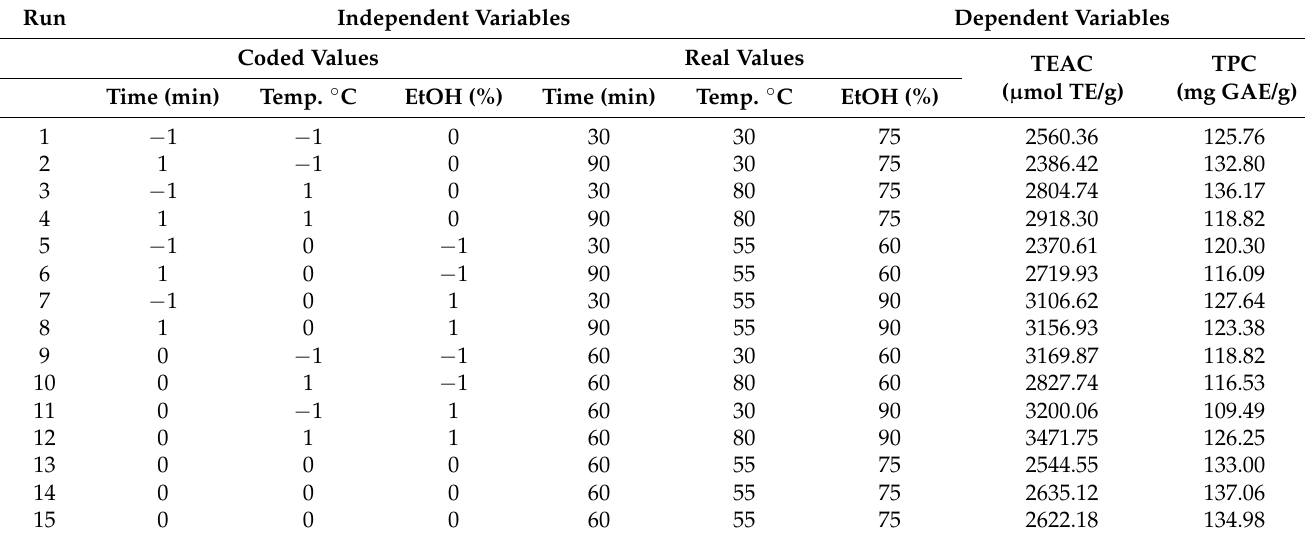
Table 1. Box–Behnken Design for the extraction of antioxidants compounds from Brazilian red propolis